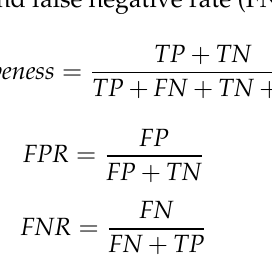
Figure 4. An example of purchasing audit report